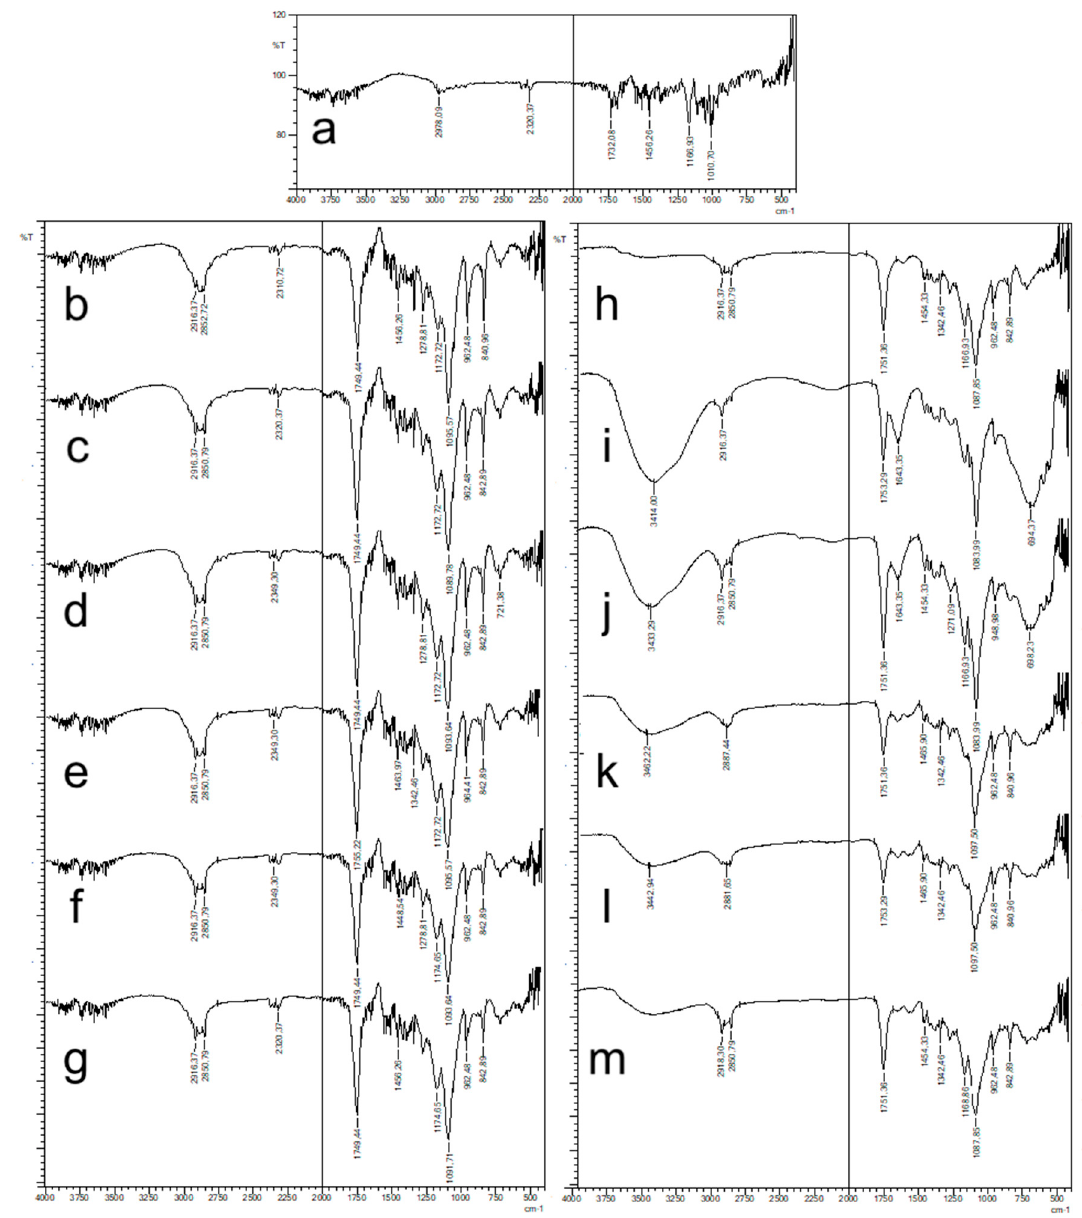
Figure 6. FT-IR spectrum of CLR and NPs, ( a ) CLR, ( b ) 502H-Blank, ( c ) 503H-Blank, ( d ) 504H-Blank, ( e ) CS-502H-Blank, ( f ) CS-503H-Blank, ( g ) CS-504H-Blank, ( h ) 502H, ( i ) 503H, ( j ) 504H, ( k ) CS-502H, ( l ) CS-503H, ( m ) CS-504H.